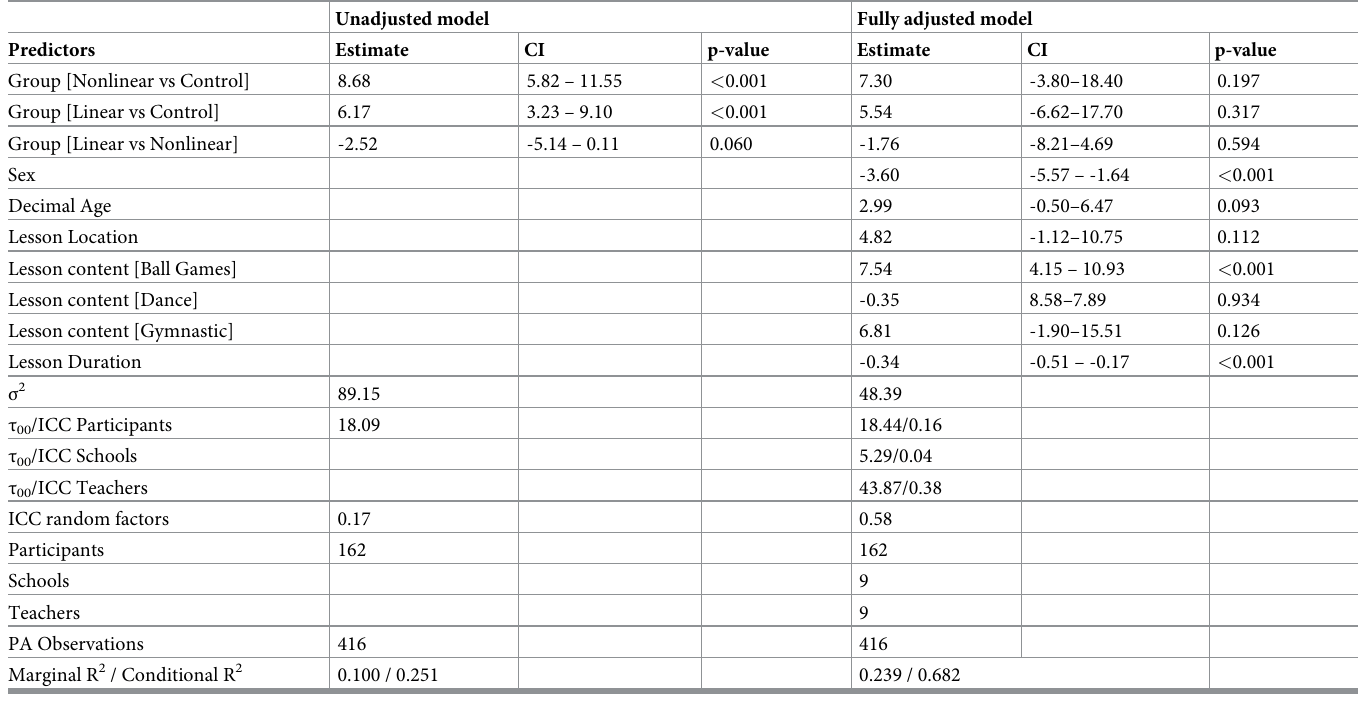
Table 5. Association between pedagogy group and children’s percentage of moderate to vigorous physical activity during physical